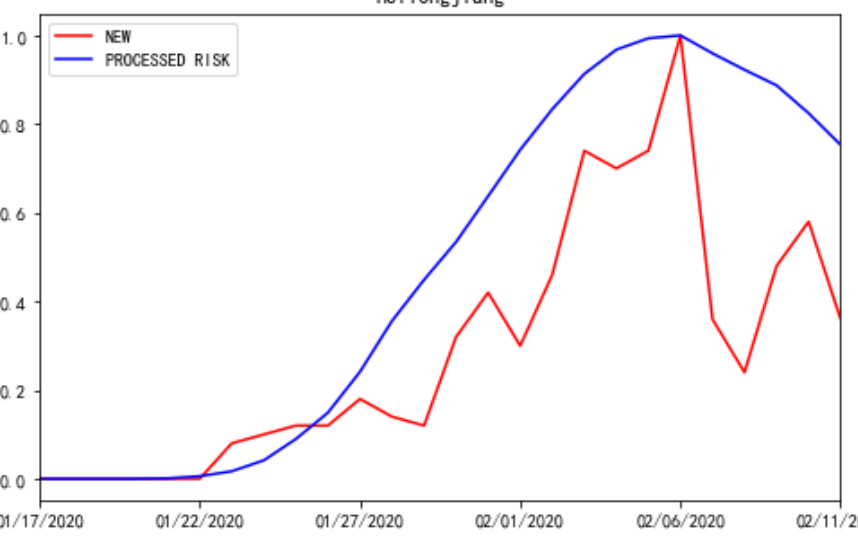
Figure 7. The polyline chart of NEW and PROCESSED RISK for Heilongjiang Province from January 17, 2020 to February 11, 2020 when OFFSET=4 and